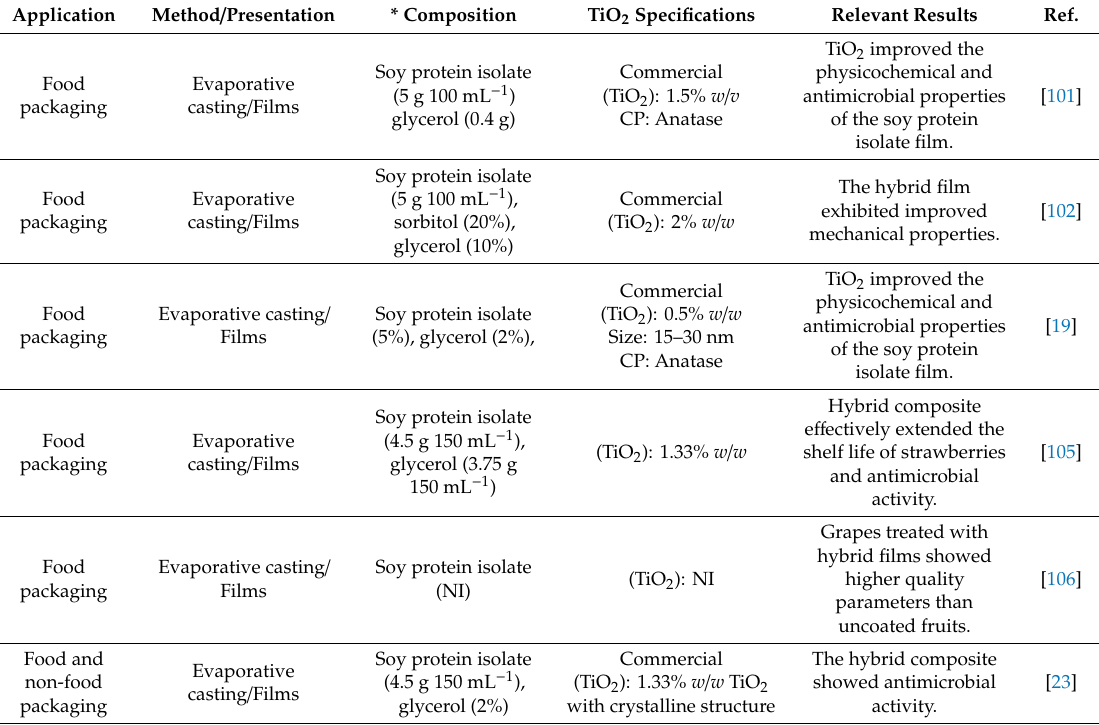
Table 7. E ff ect of TiO 2 incorporation on soy protein isolate-based